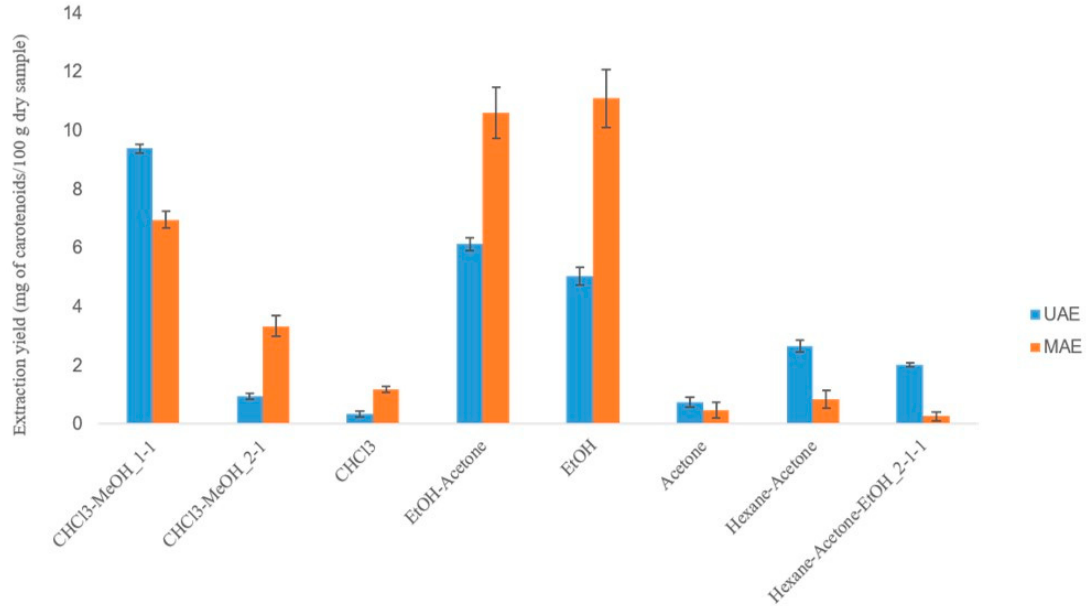
Figure 2. Selecting the optimal ultrasound-assisted extraction (UAE) and microwave-assisted extraction (MAE) solvent system for carotenoid extraction from apricot pulp.